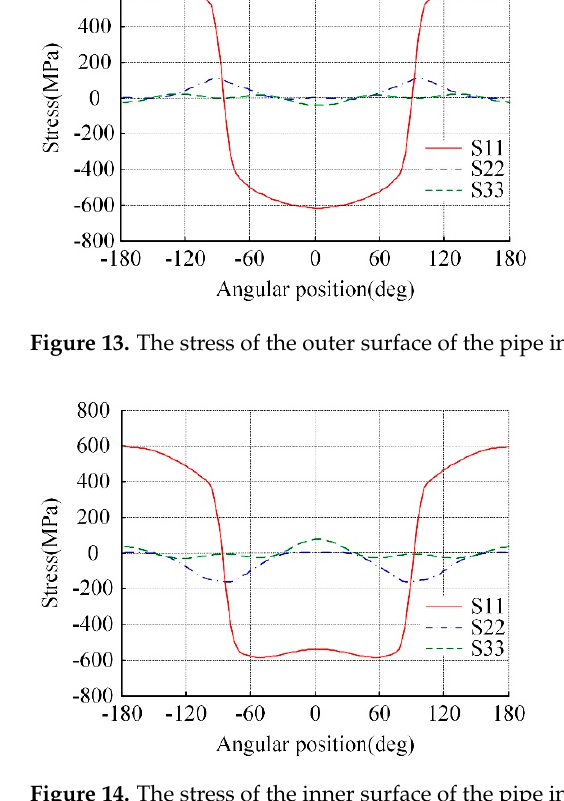
Table 2. Comparison of results.